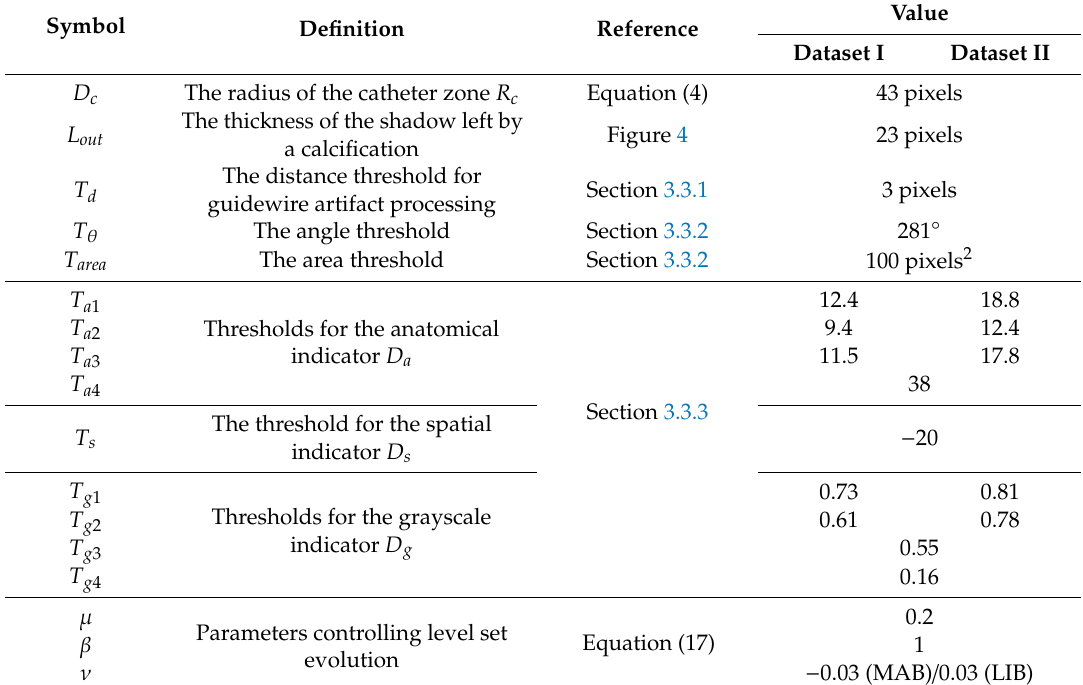
Figure 5. An example of the assignment flow on the regions of interest (ROIs), ( a ) media-adventitia border (MAB) initialization, ( b – g ) assignment of ROIs in B_1 and update of MAB, ( h ) B_2, ( i ) assignment of ROIs in B_2, ( j ) lumen-intima border (LIB) extraction. Table 2. Parameter selection in the proposed